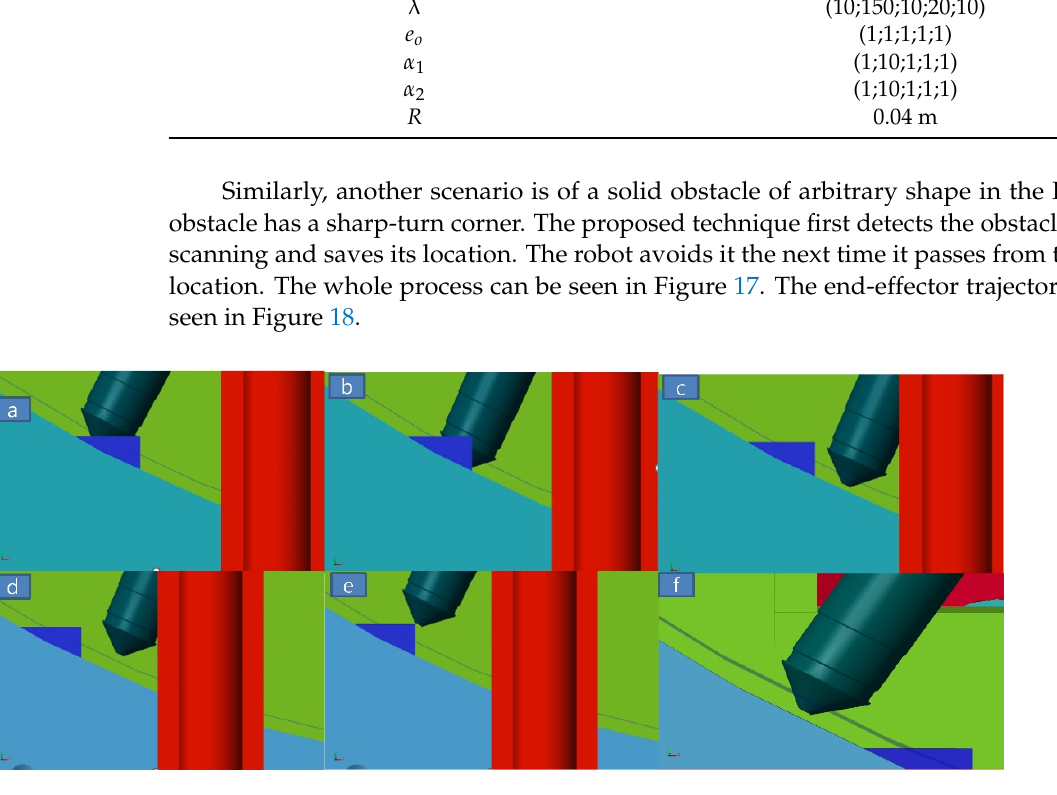
Figure 18. Sharp-turn corner obstacle avoidance trajectory (end-effector) . Third, the RVI wall is considered a continuous obstacle. The information regarding the obstacle is unknown. Therefore, according to proposed technique, the robot first de- tects and scans the obstacle position and records it, using the proposed estimated external disturbance torque. When the robot passes the same position, a repulsive force acts to